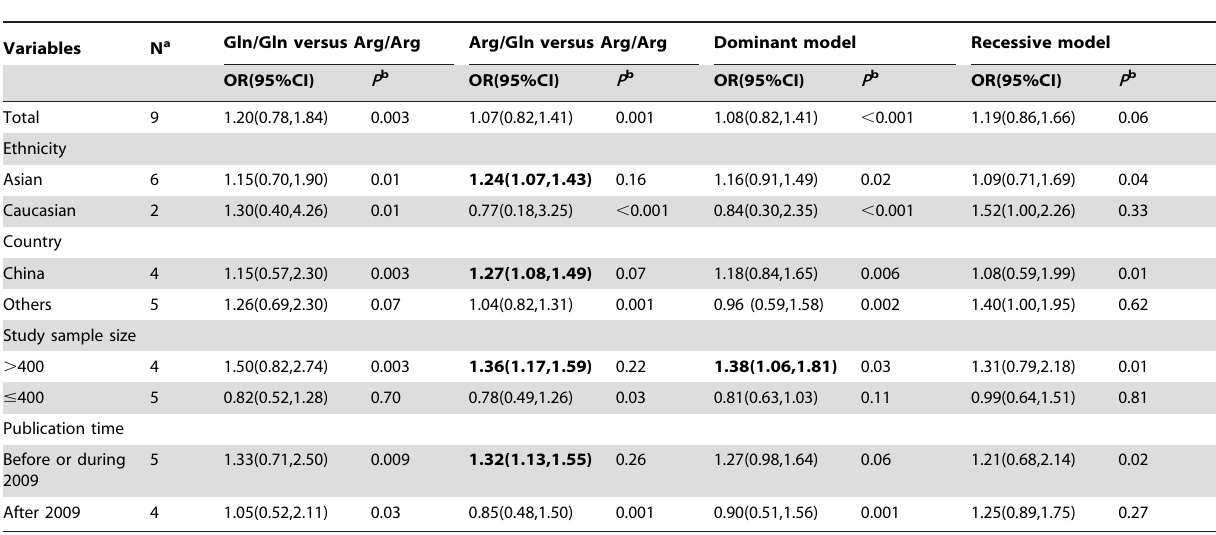
Table 3. Stratified analyses of the XRCC1 polymorphism Arg399Gln on cervical cancer (CC) risk.